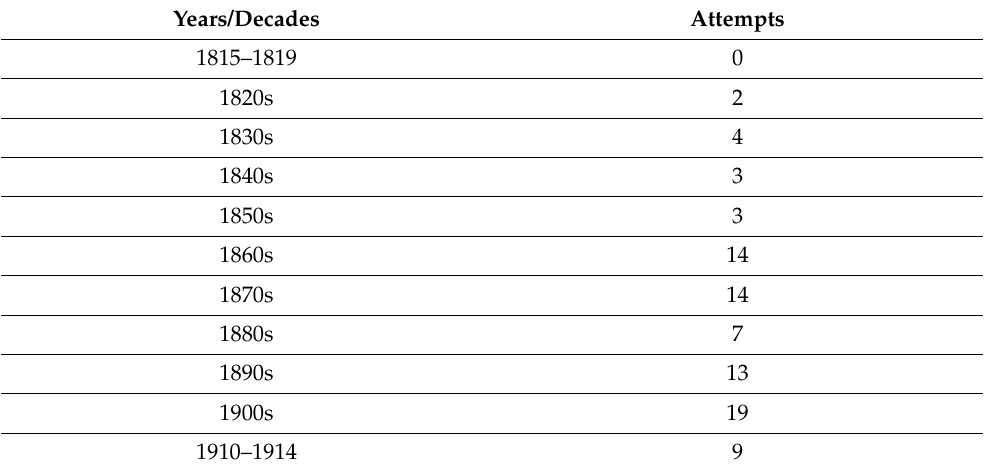
Table 1. Approximate number of assassinations and attempts on heads of state globally by